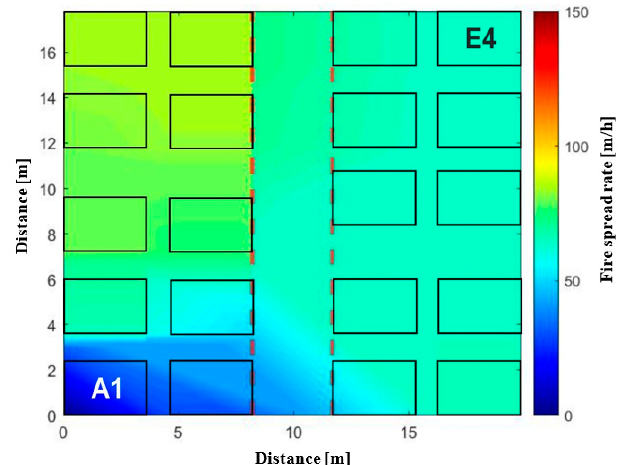
Figure 14. Colour map depicting the fire line progression rate relative to time zero and pattern of the baseline simulation, where only dwelling A1 is ignited with the 3.5 m fire break marked by dotted red lines.